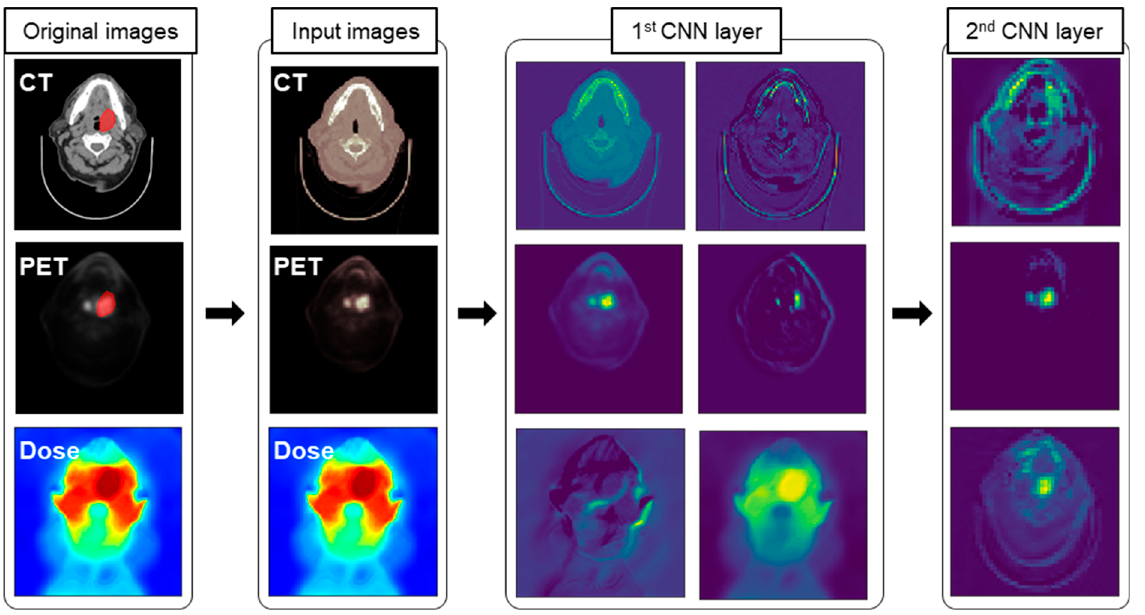
Figure 2. Visualized activation maps of the CPD-C (CT+PET+Dose+clinical factors) model. The first, second, and third rows of activation maps in the 1st CNN layer were extracted from conv3d_1, conv3d_2, and conv3d_3, respectively (See the architecture in Table S3). Activation maps in the 2nd CNN layer were extracted from conv3d_4.